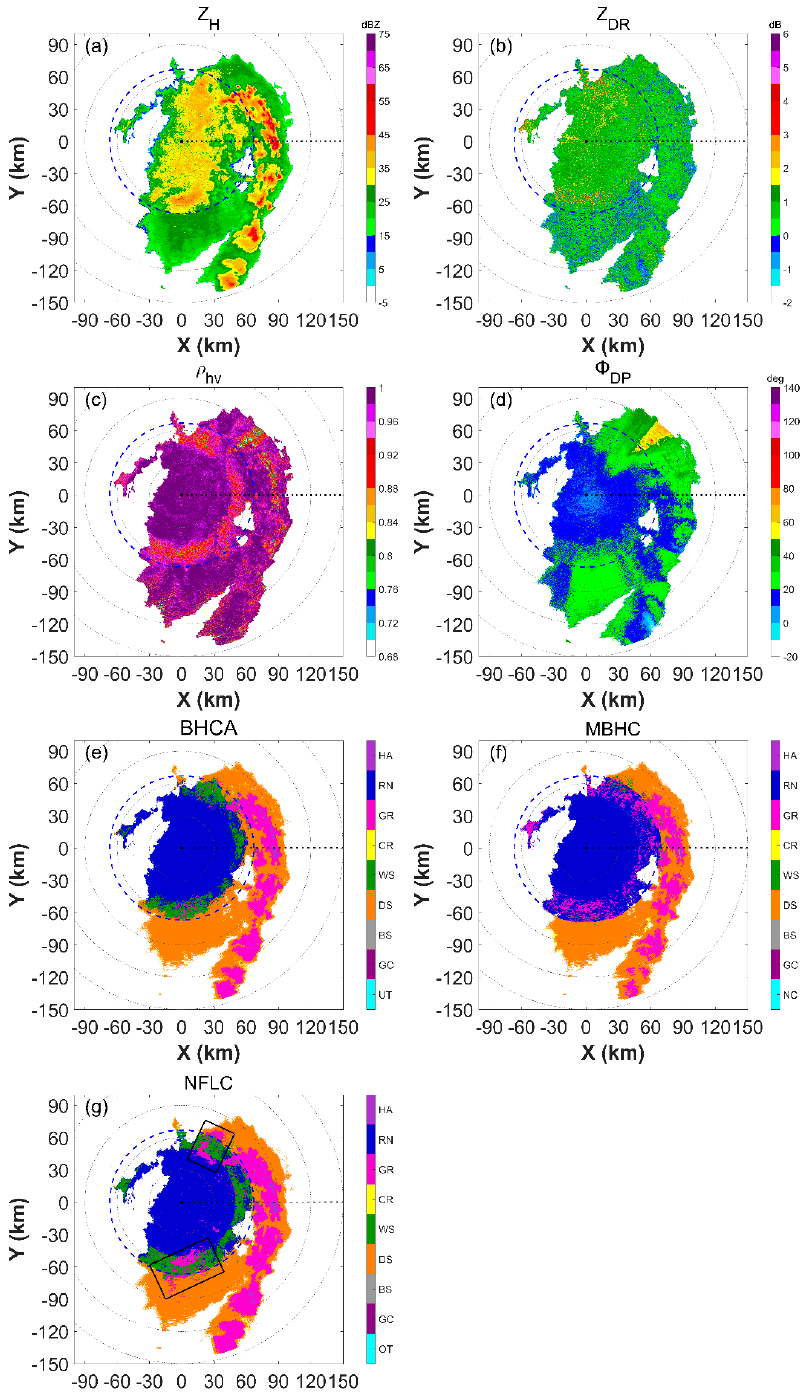
Figure 3. Plan position indicator (PPI) of ( a ) Z H , ( b ) Z DR , ( c ) ρ hv , ( d ) Φ DP , and corresponding hydrometeor classification results by ( e ) the Bayesian hydrometeor classification algorithm (BHCA), ( f ) Marzano-Bayesian hydrometeor classification algorithm (MBHC) and ( g ) NCAR fuzzy logic classifier (NFLC) at 4.3 ° elevation angle at 23:04 LST on 30 July 2014. The blue dash circle represents freezing level determined from sounding data, and the black dash line shows the azimuth of range-height indicator (RHI) scan in Figure 4. The black rectangles highlight the different output classification. Each range ring represents 30 km distance of interval away from radar site.